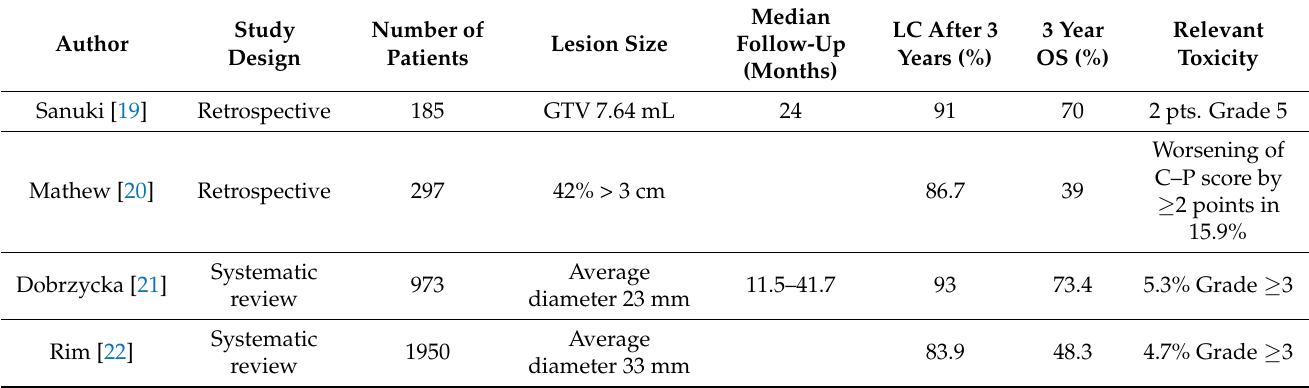
Table 3. Results of SBRT for HCC (small tumors) in the largest retrospective studies and systematic